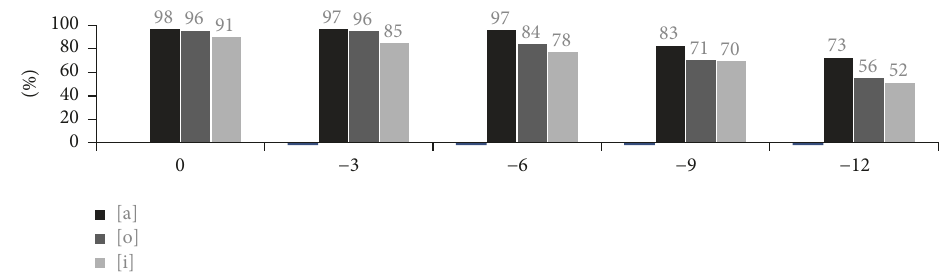
Figure 11: Correct recognition of vowels in first stressed syllable against pink noise.